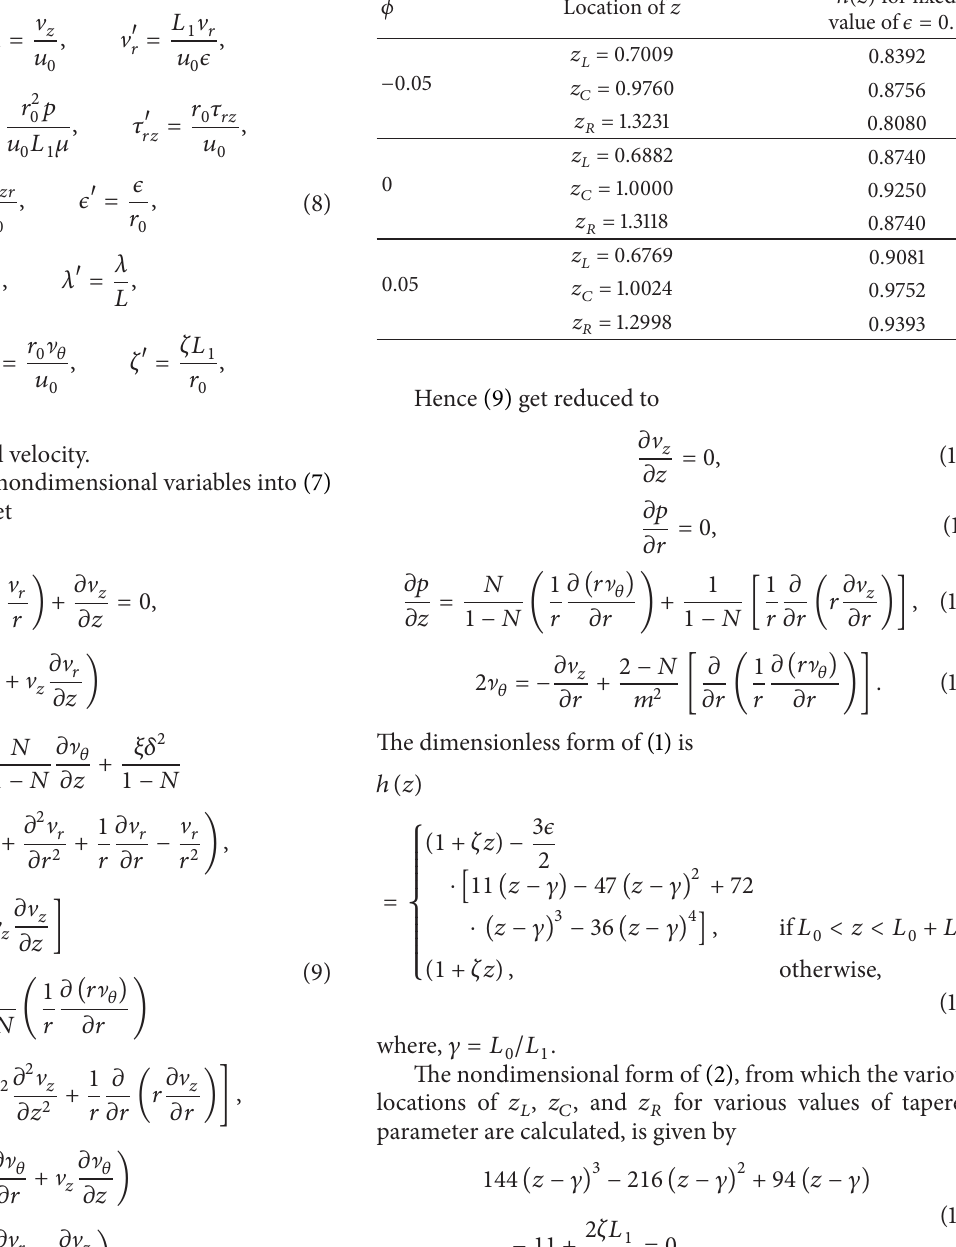
ℎ(𝑧) for fixed value of 𝜖 =